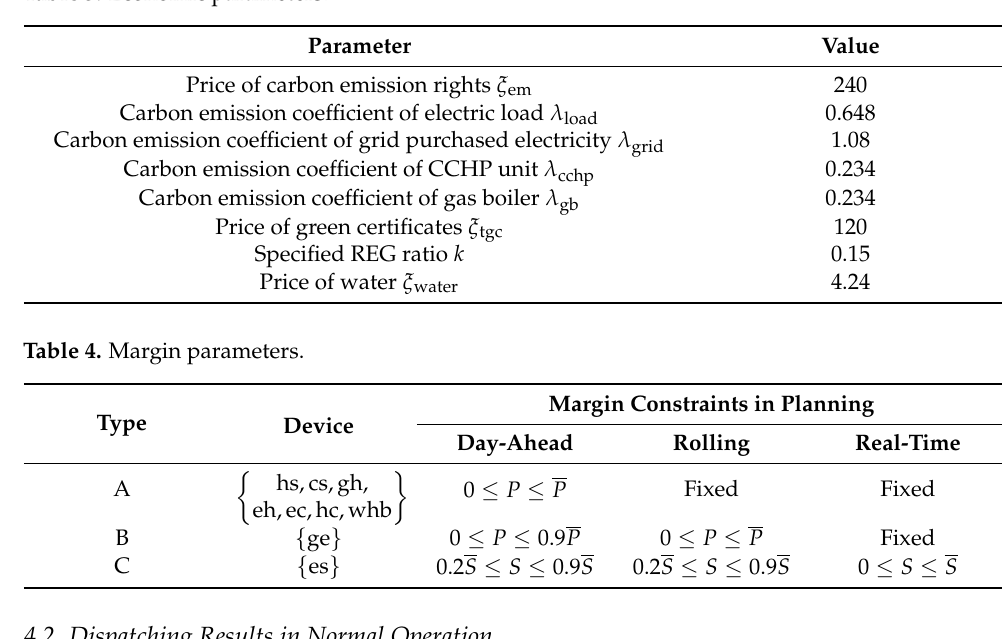
Table 3. Economic parameters.